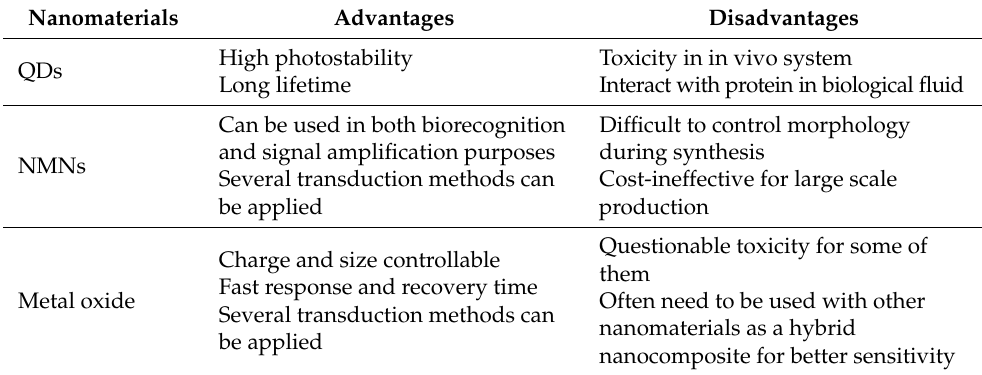
Table 4. Comparison of important features of different groups of nanomaterials discussed in preced- ing paragraph for cytokine biosensors